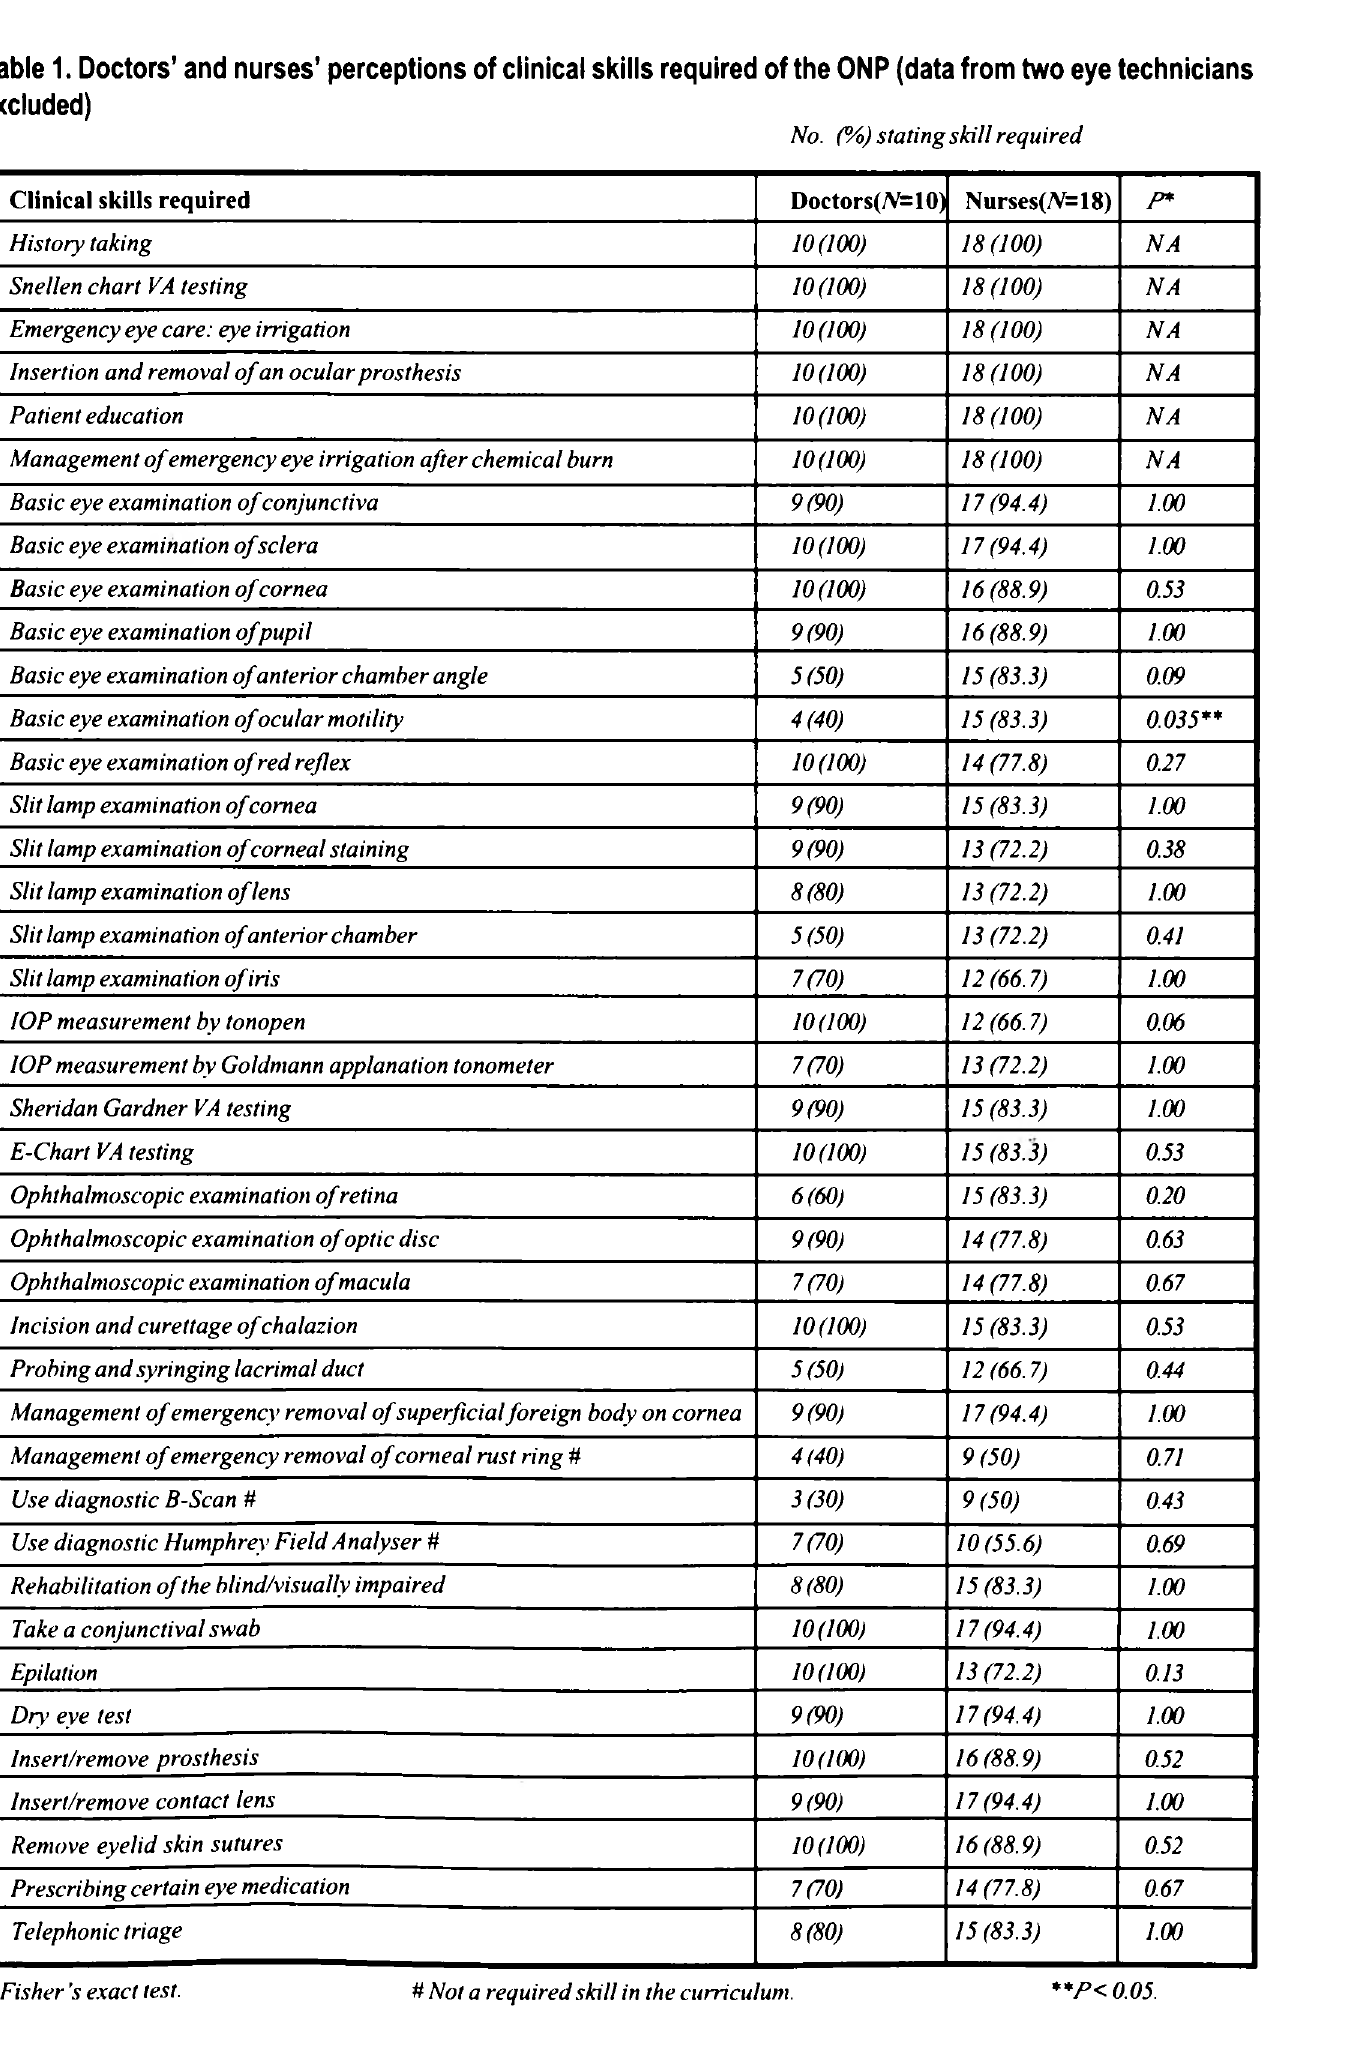
Table 1. Doctors’ and nurses’ perceptions of clinical skills required of the ONP (data from two eye technicians